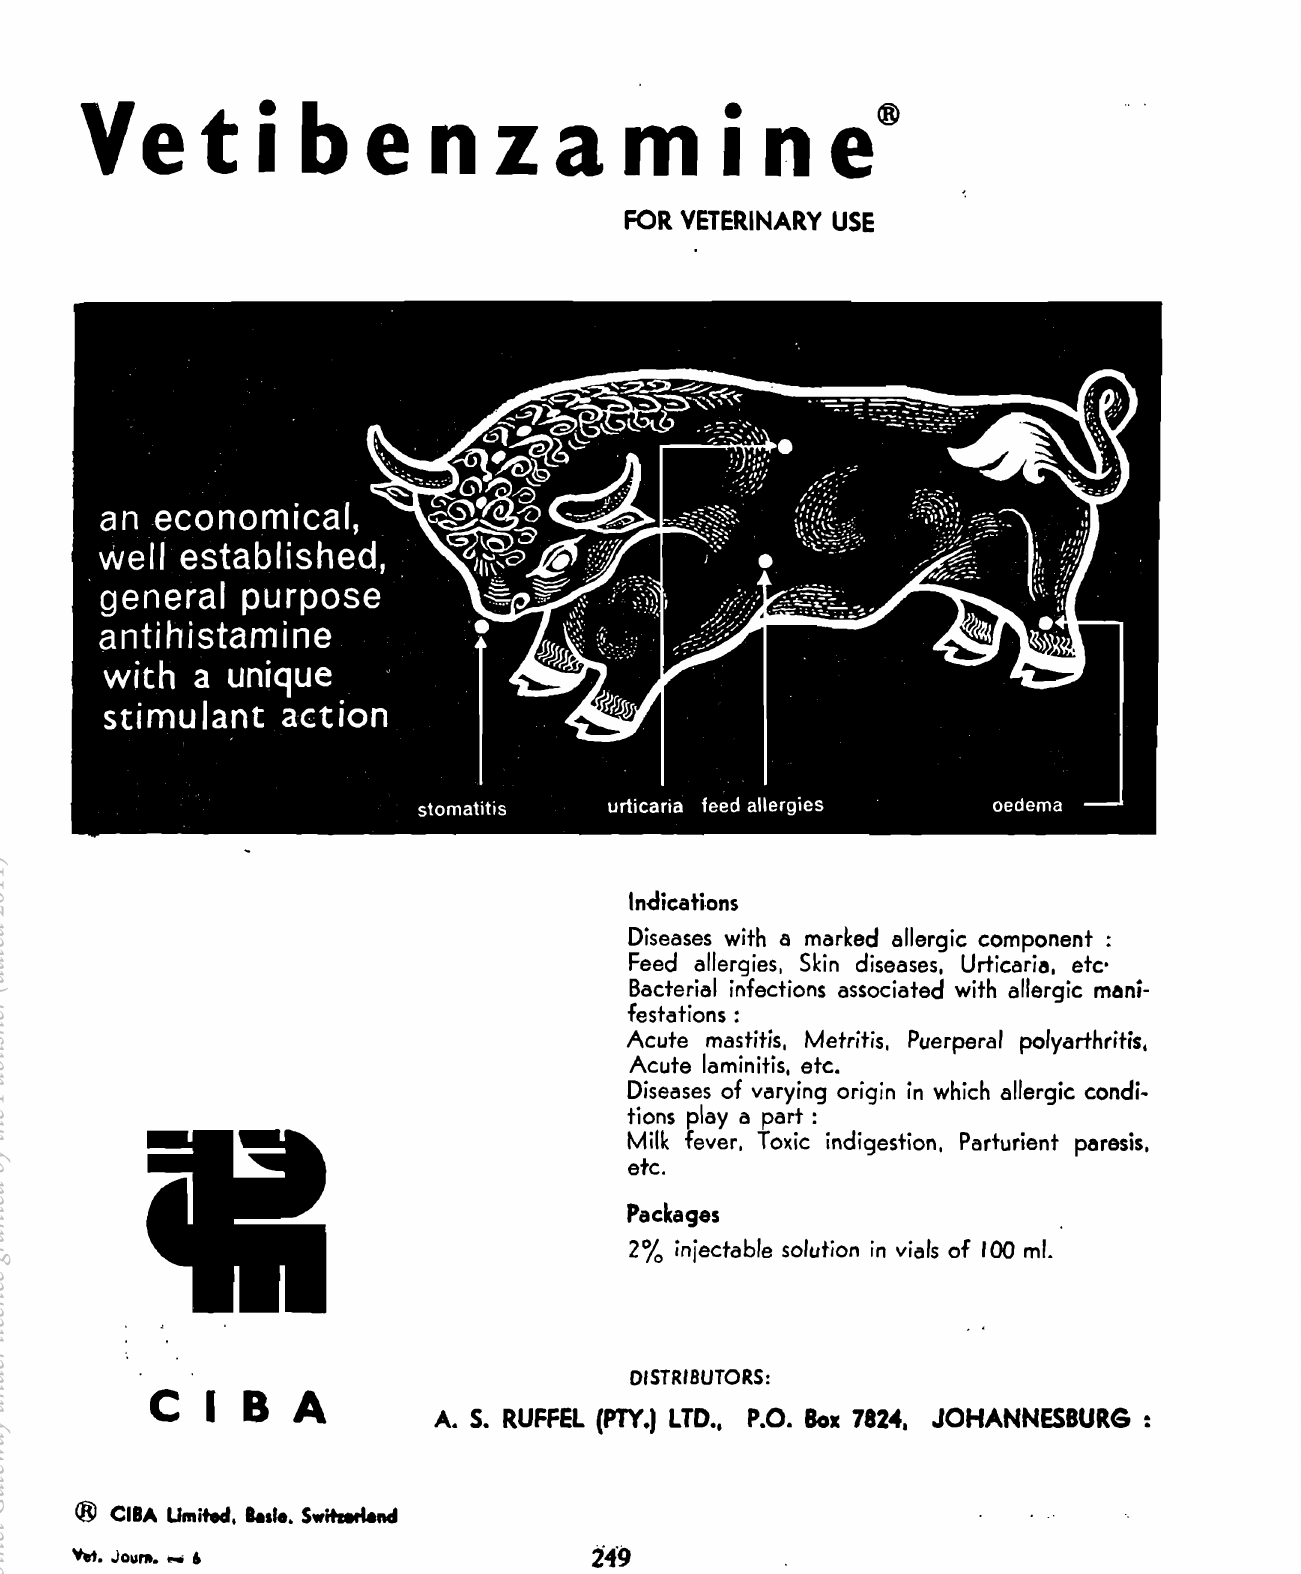
Indications Diseases with a marked allergic component : Feed allergies, Skin diseases, Urticaria, etc' Bacterial infections associated with allergic mani festations : Acute mastitis, Metritis, Puerperal polyarthritis, Acute laminitis, etc. Diseases of varying origin in which allergic condi tions play a part : Milk fever, Toxic indigestion, Parturient paresis, etc. Packages 2% injectable solution in vials of 100 ml.